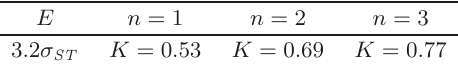
Fig. 3. Determination of K coefficient. Table 6. Calculation of the K coefficient.